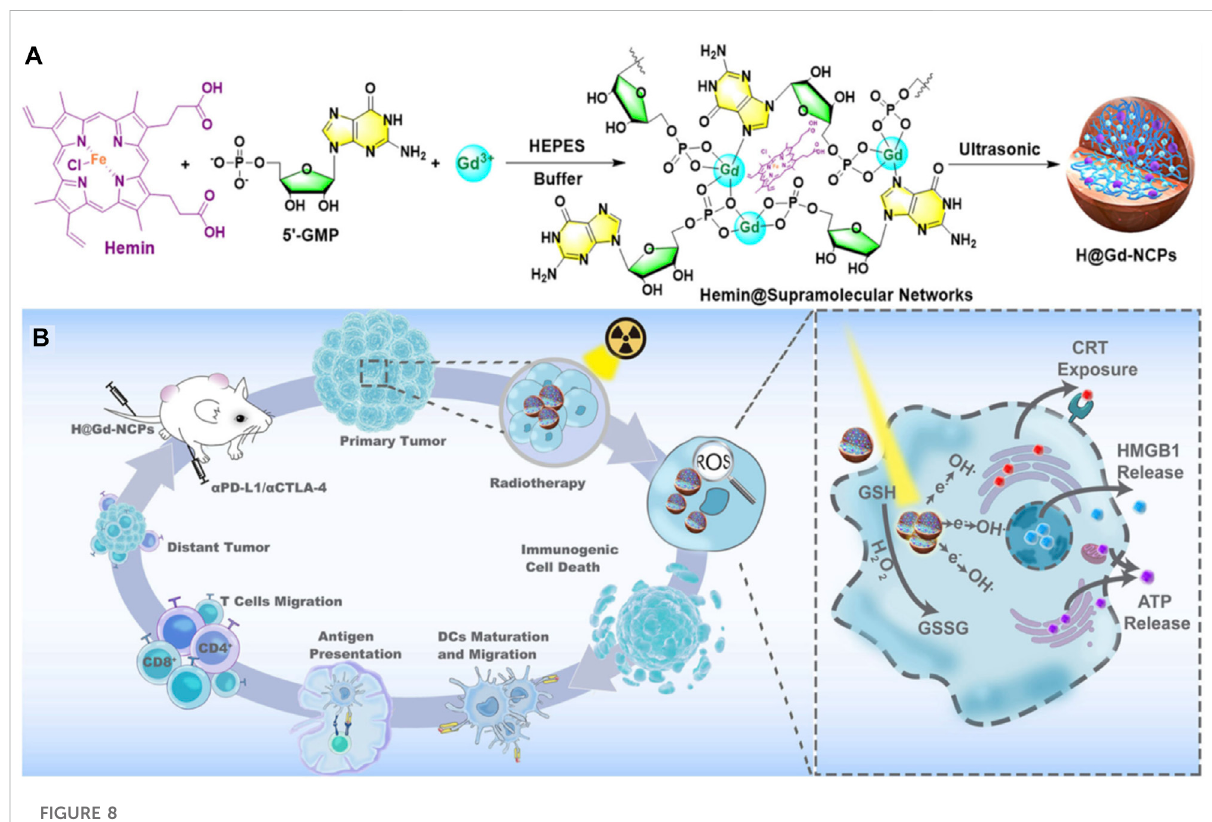
FIGURE 8 (A,B) The preparation and mechanism of action of H@Gd-NCPs (Huang et al.,